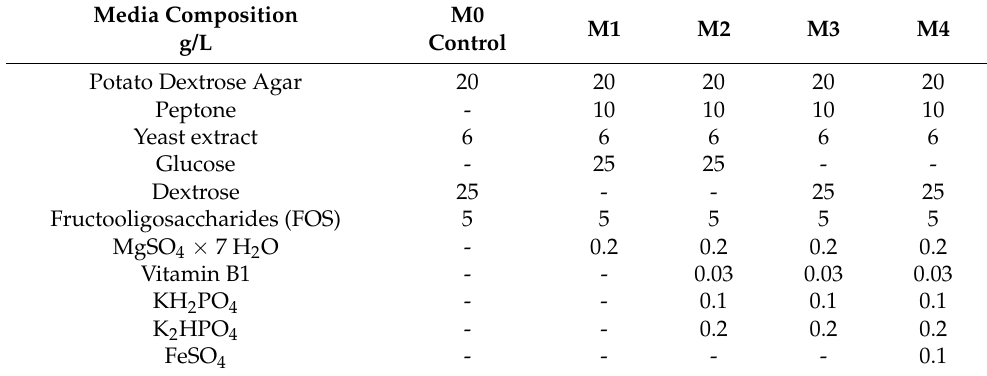
Table 1. Liquid culture media composition for fresh mycelial culture.